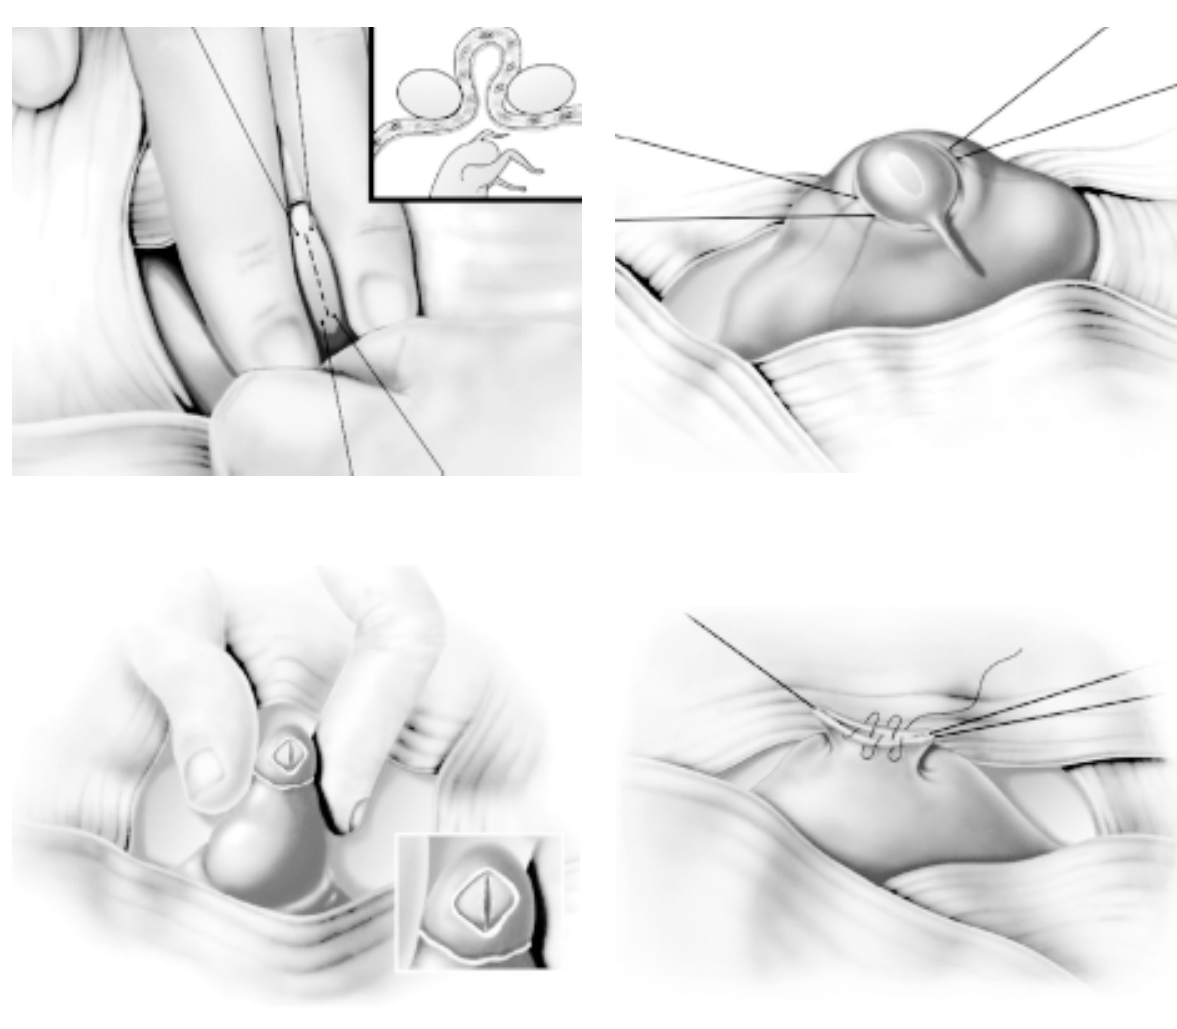
FIGURA 1 - Desenho esquemÆtico da tØcnica cirœrgica usada para cria(cid:231)ªo da meningomielocele em fetos de coelho. (A) Duas suturas de reparo foram aplicadas contemplando as membranas fetais (detalhe), precedendo a abertura do miomØtrio. (B) Apenas a cauda fetal Ø exposta para manter o feto posicionado; Ø removida de uma Ærea de pele, expondo os processos espinhosos (pontos brancos). (C) Incisªo sobre o processo espinhoso sendo feita. Observar a abertura do canal espinhal e conseq(cid:252)ente exposi(cid:231)ªo da medula. Notar a pressªo aplicada (cid:224) inser(cid:231)ªo dos membros posteriores do feto que auxilia na exposi(cid:231)ªo da medula. (D) Sutura invaginante aplicada para o fechamento do miomØtrio, incluindo as membranas